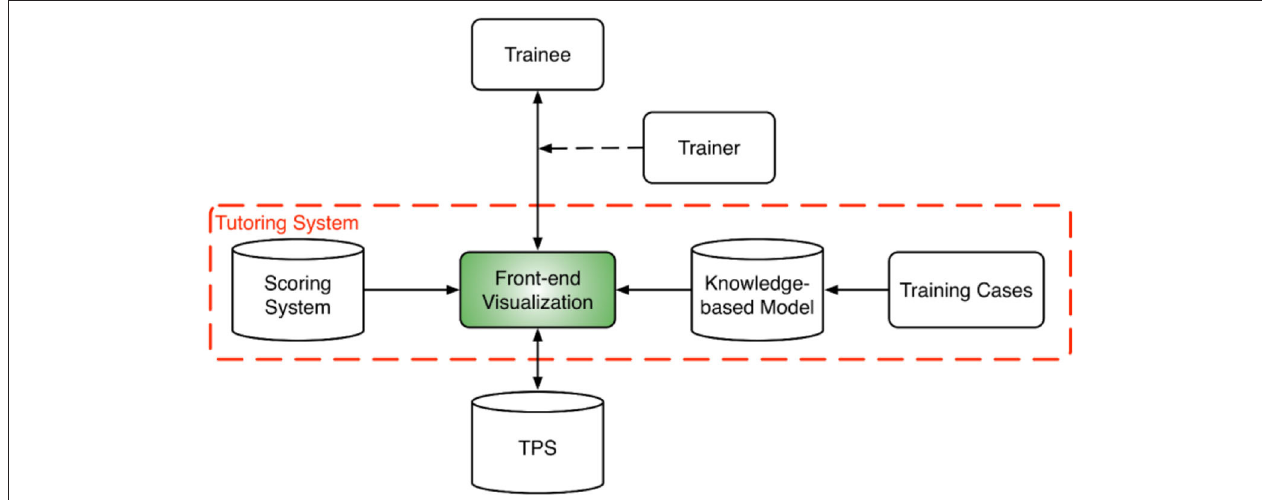
FIGURE 1 | System design diagram for the training program which includes a tutoring system at its core and a host of training cases. The tutoring system brings together the trainee, trainer, and the TPS. A trainer is optional for assisting the interaction between the trainee and the tutoring system. The tutoring system is powered by a scoring system and a set of knowledge